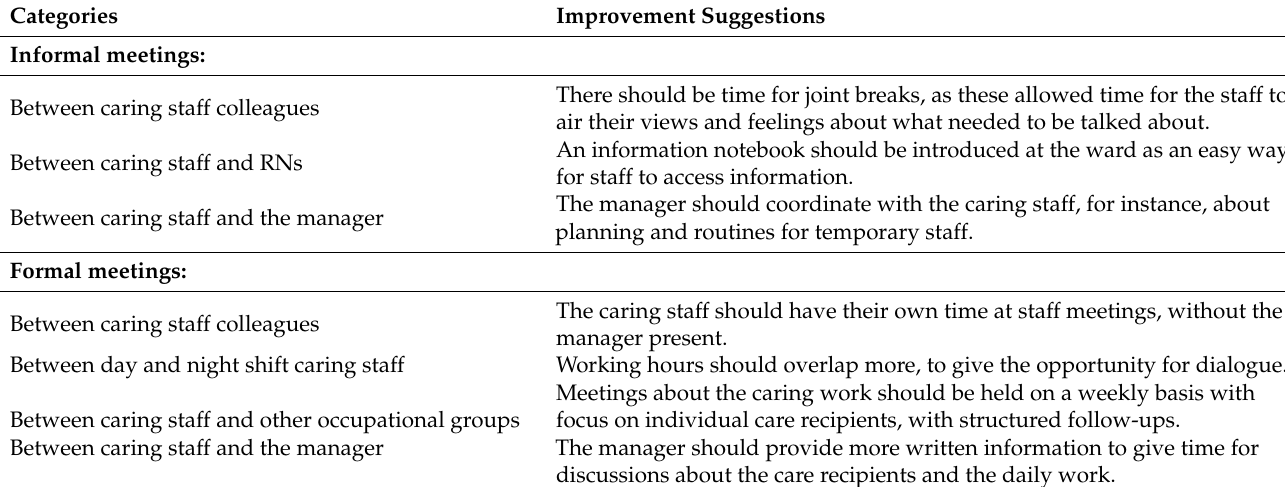
Table 2. The two categories of meetings that lead to flourishing of different work relationships, and participants’ (condensed) suggestions for improvement